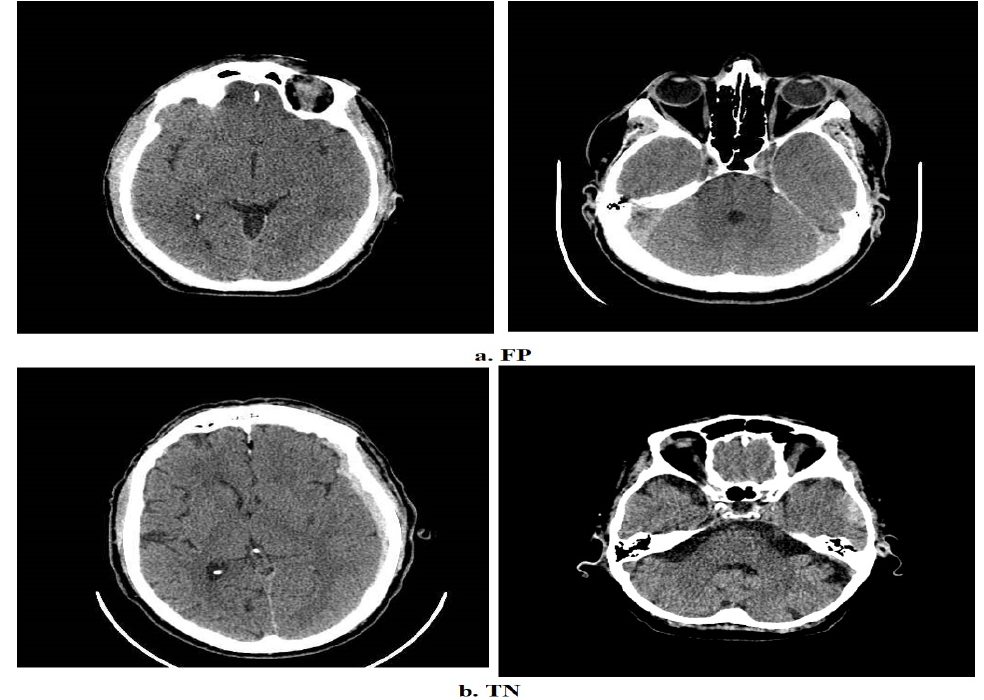
Figure 22. Four samples from the hemorrhagic data set which were incorrectly